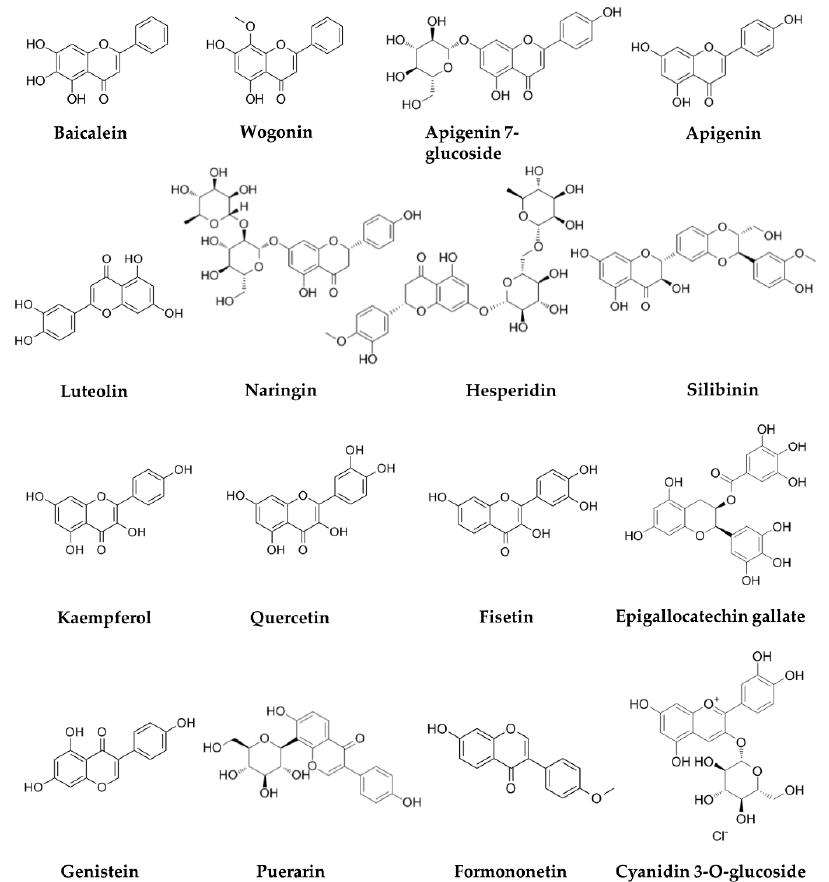
Figure 1. Chemical structure of several flavonoids against cervical cancer. Table 1. Effect and mechanism of flavonoids on cervical cancer.